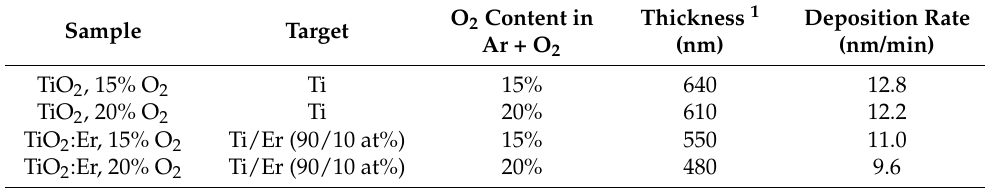
Table 1. Parameters of thin films deposition